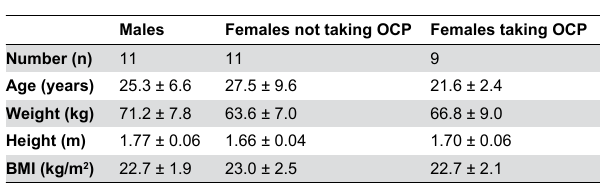
Table 1. Demographics of the study subjects grouped according to gender and whether taking the oral contraceptive pill (OCP).